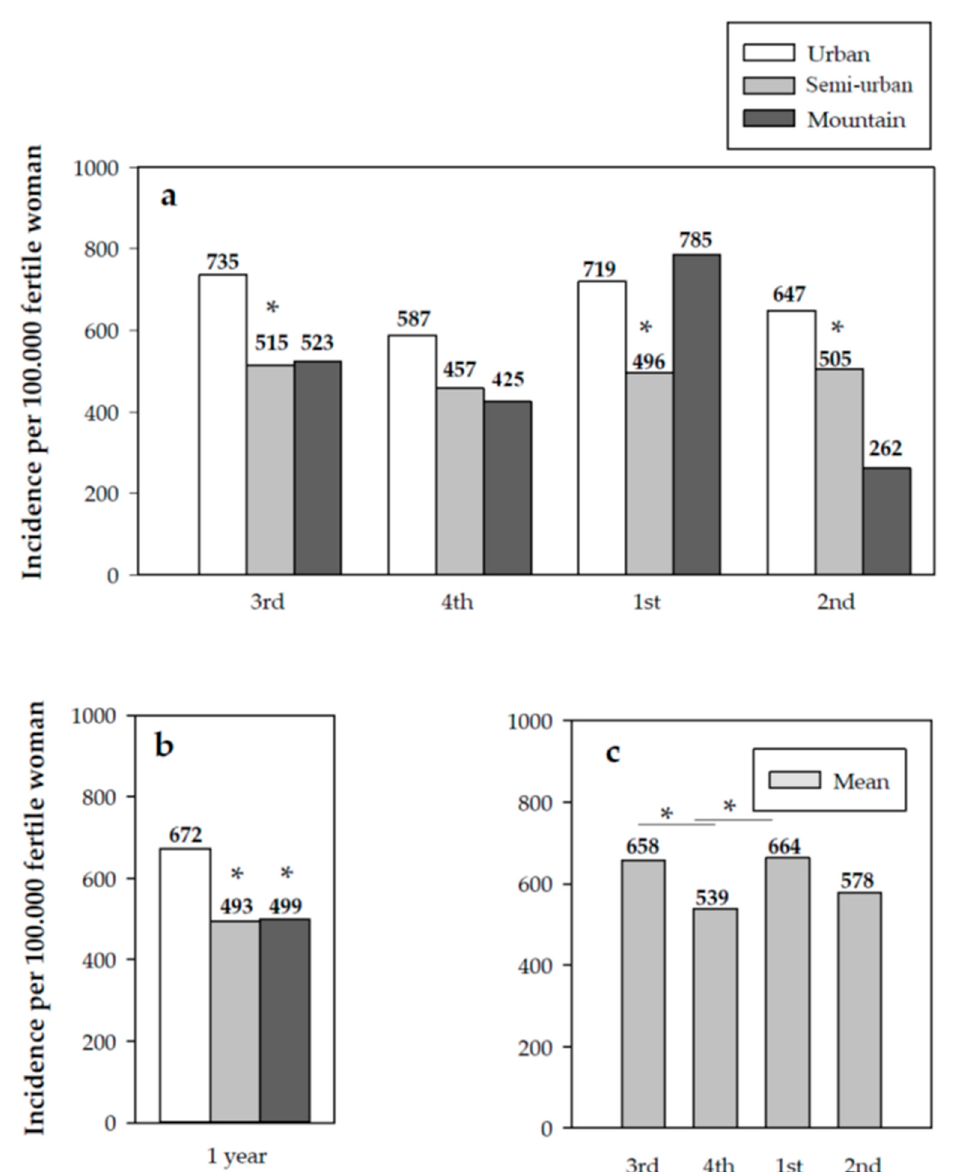
Figure 2. ( a ) Quarterly cumulative incidence by type of geographical area; ( b ) annual cumulative incidence by type of geographical area; ( c ) quarterly cumulative incidence in Catalonia. Significant differences: ( a , b ) * vs. urban area ( p < 0.05); ( c ) * p < 0.05.